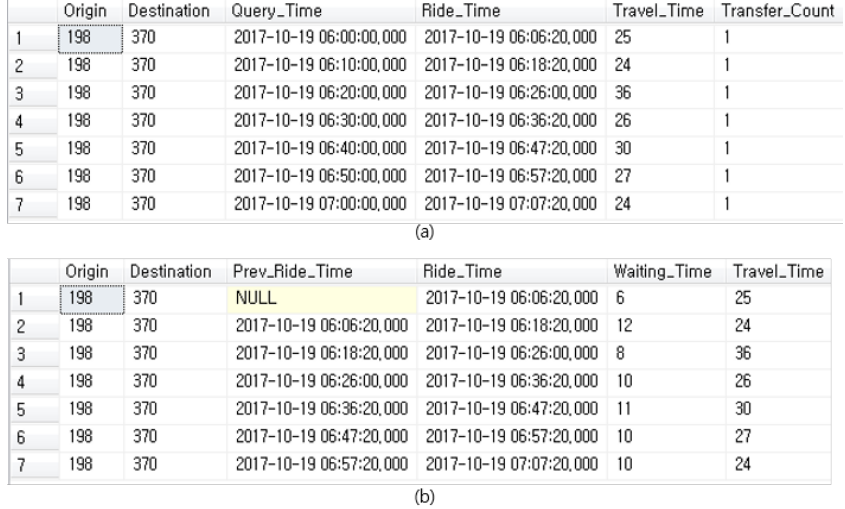
Figure 2. Example of minimum travel time route search result (a) and wait time calculation (b)